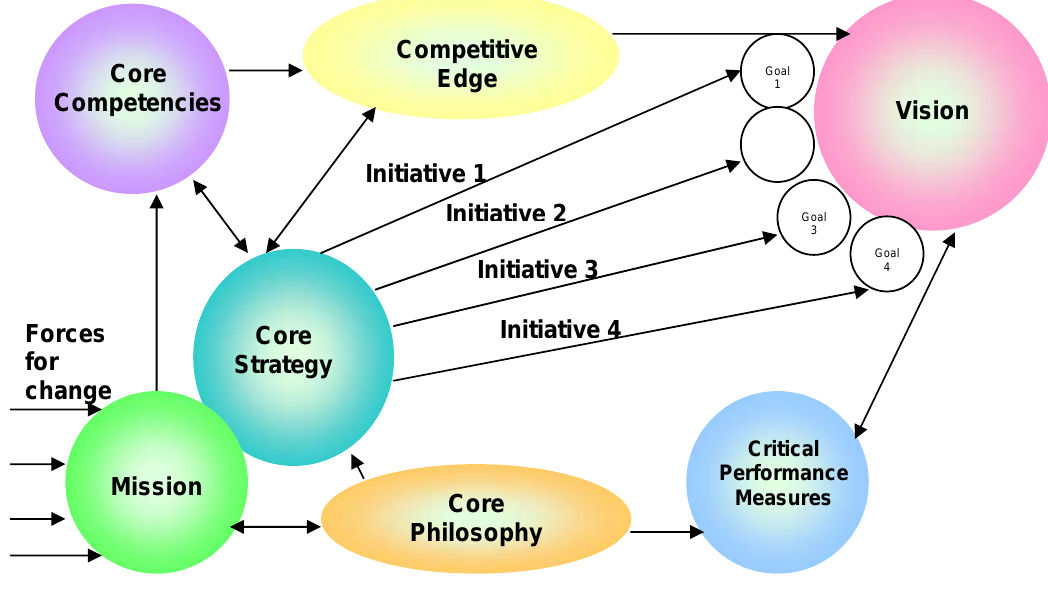
Figure 3: A generic strategic